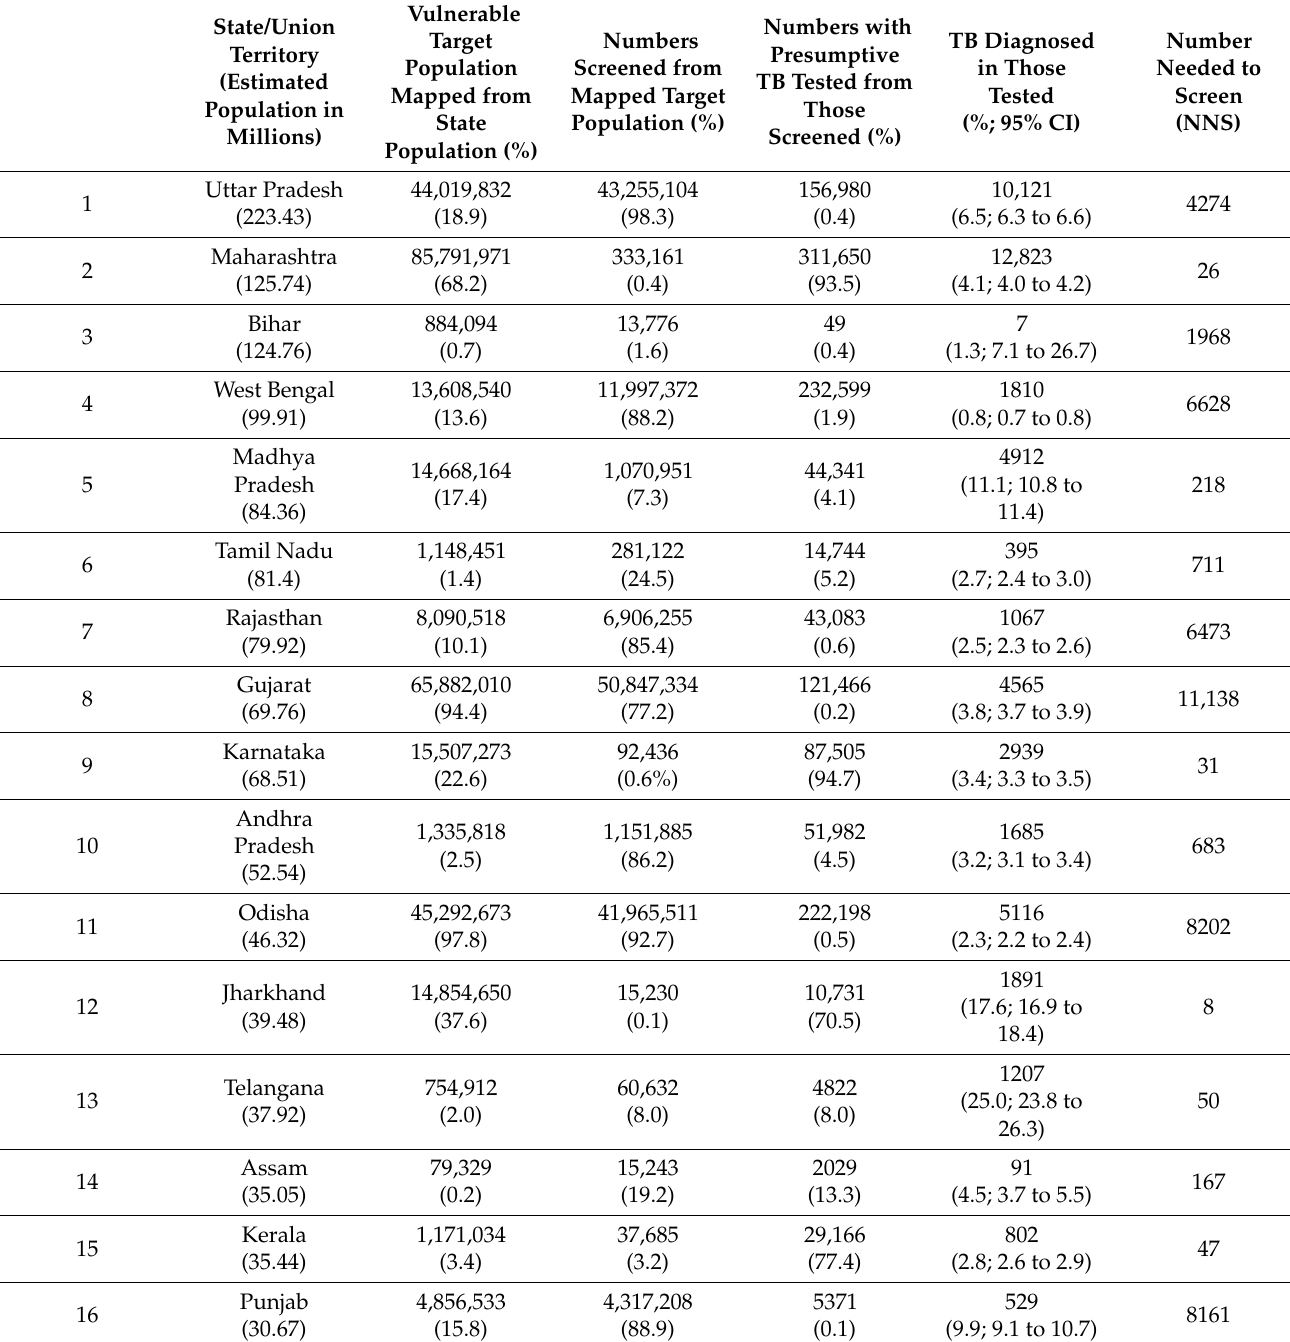
Table 4. Summary data from the National Tuberculosis Elimination Programme for the active case finding (ACF) activities in 2020 from the states and union territories (ranked by population size)